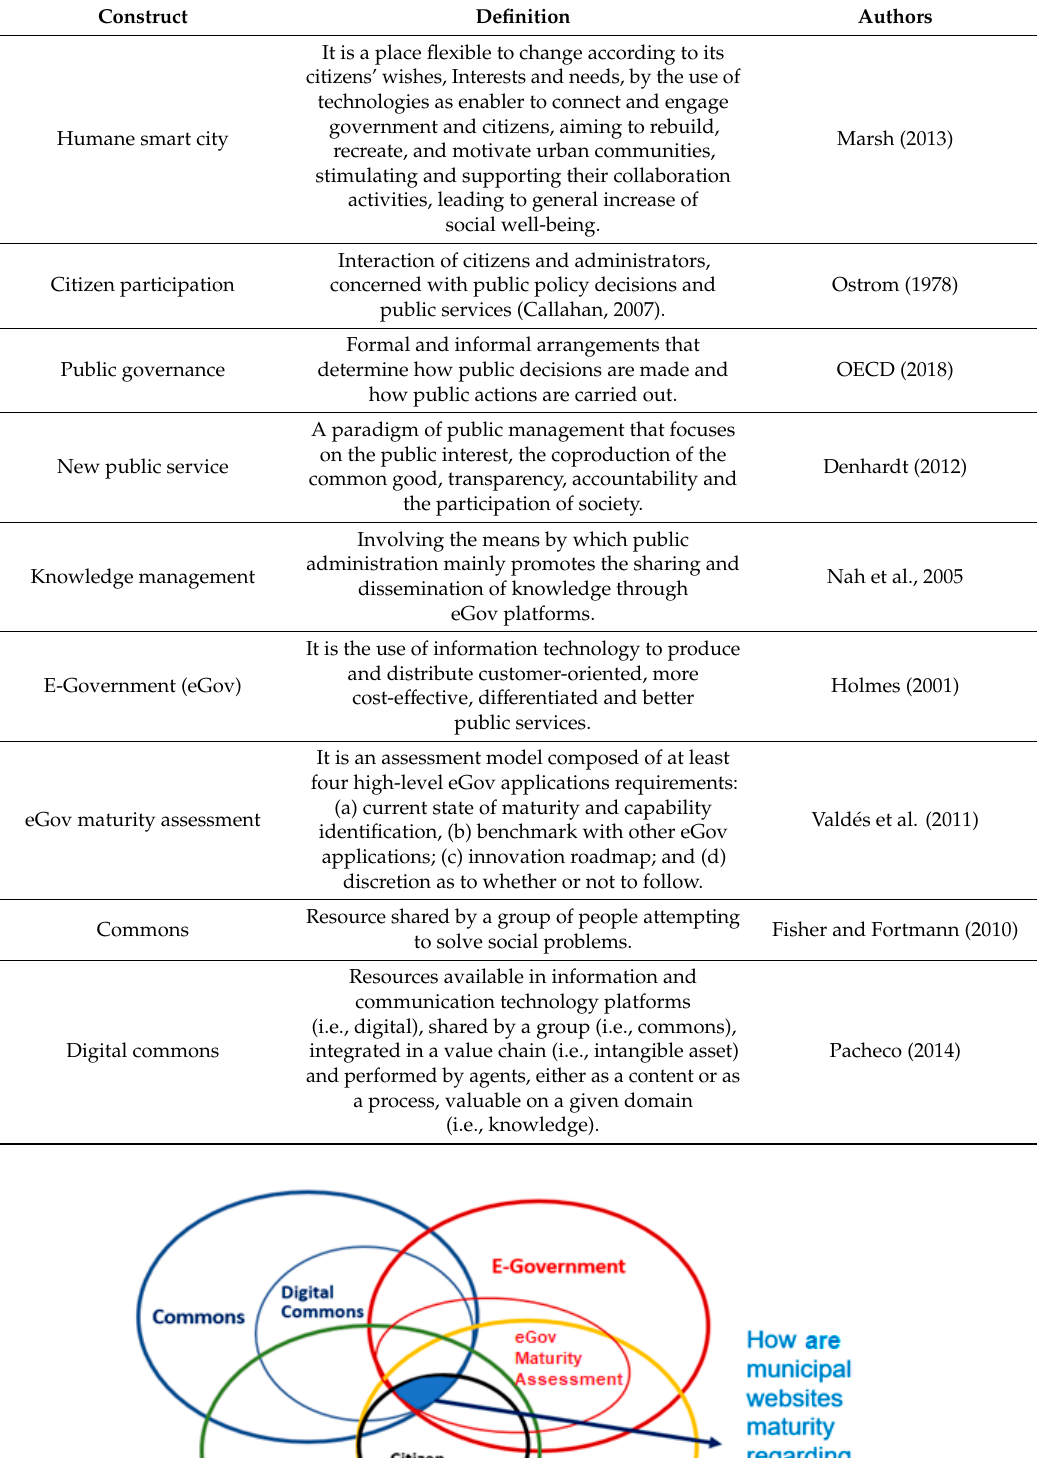
Table 1. Conceptual references of MEPA.